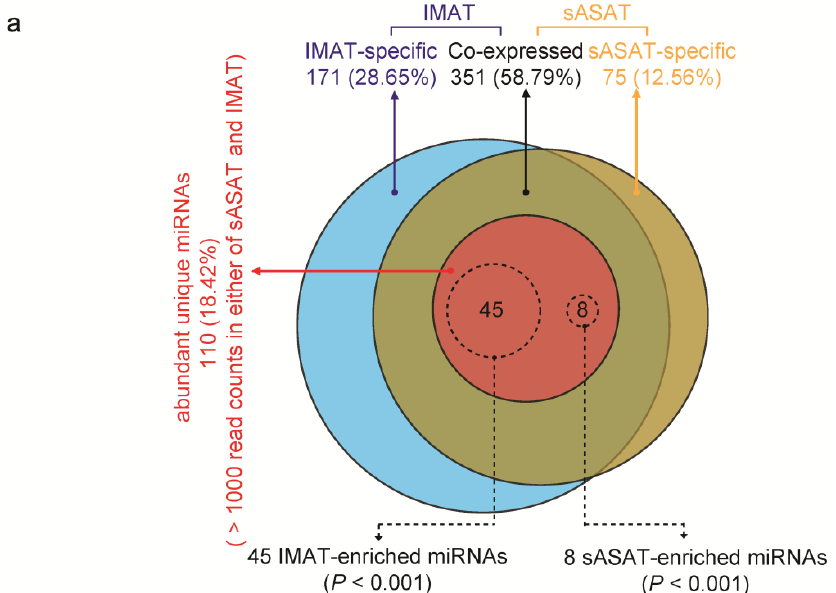
Figure 2. Characteristics of the differentially expressed (DE) miRNAs between porcine sASAT and IMAT. ( a ) Distribution of 597 unique miRNAs between sASAT (blue) and IMAT (yellow). The red circle represents the 110 miRNAs with read counts >1000 in either of the two libraries. The dashed circles indicate the 45 IMAT-enriched ( left ) and eight sASAT-enriched ( right ) miRNAs ( p < 0.001); ( b ) q-PCR validation for the top 14 DE miRNAs with highest read counts between IMAT and sASAT. Pearson’s correlation was used to determine the relationship between the q-PCR and small RNA-seq results for miRNA expression levels. IMAT-NE and sASAT-NE represent normalized expression levels for the miRNAs in the IMAT and sASAT libraries, respectively; ( c ) The differential expression of 19 inflammation- and diabetes-related miRNAs between IMAT and